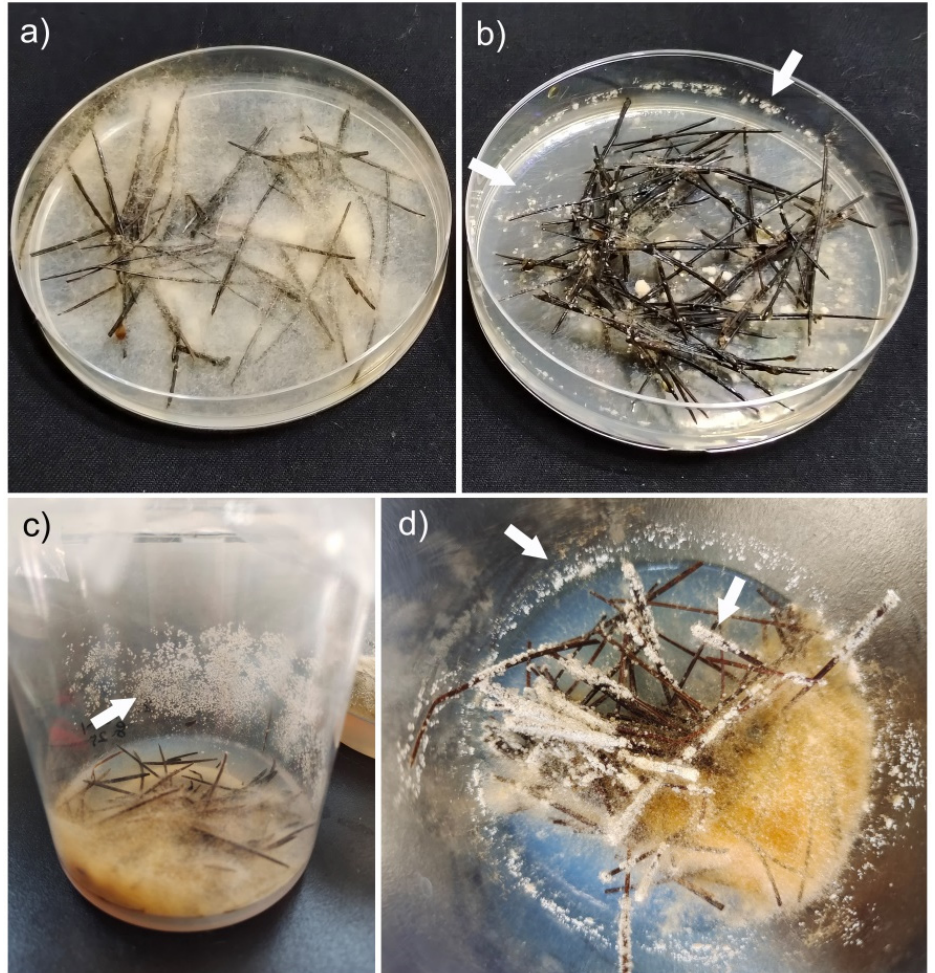
Figure 1. Induction conditions of mitotic sporogenesis. ( a ) Conventional cultivation in a 1 cm-high plate without the presence of mitospores. ( b , c ) Abundant mitospore formation in a 1.5 cm high cultivation plate ( b ) and a 10 cm height culture bottle ( c ). ( d ) Close-up picture showing abundant mitospore mat formation (arrowed) on both the container walls or over the pine needle surface.